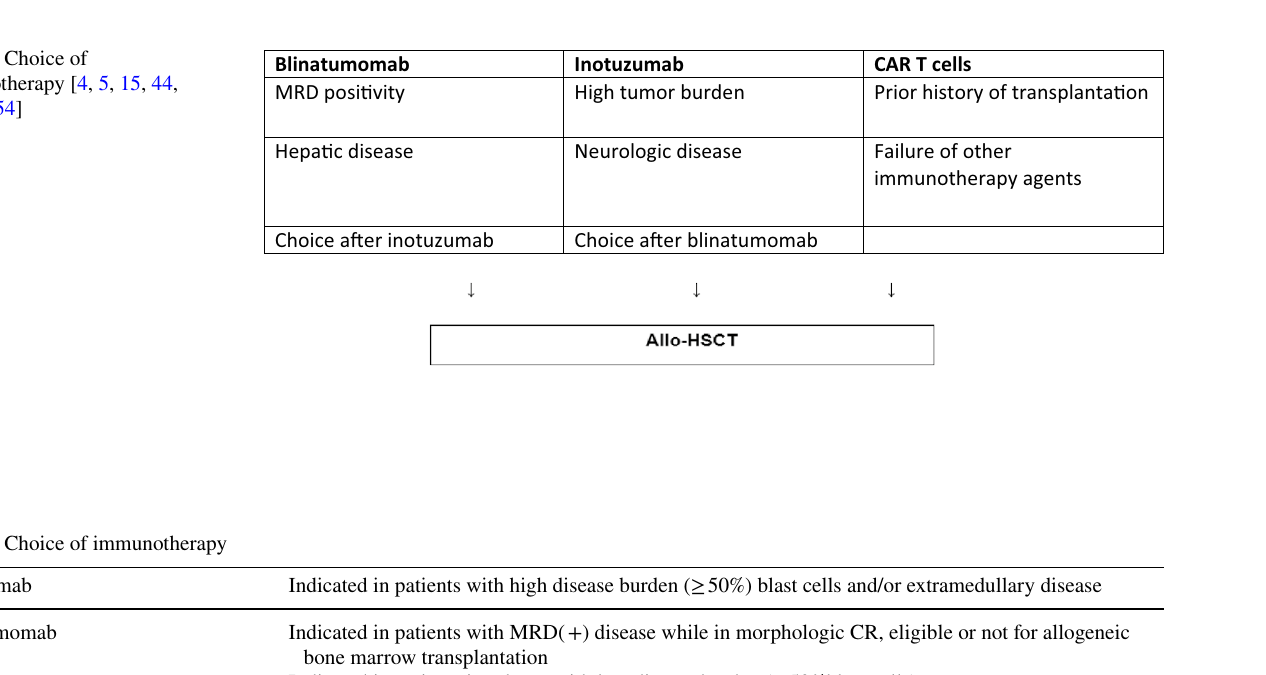
AgencyInotuzumab Indicated in patients with high disease burden (≥ 50%) blast cells and/or extramedullary